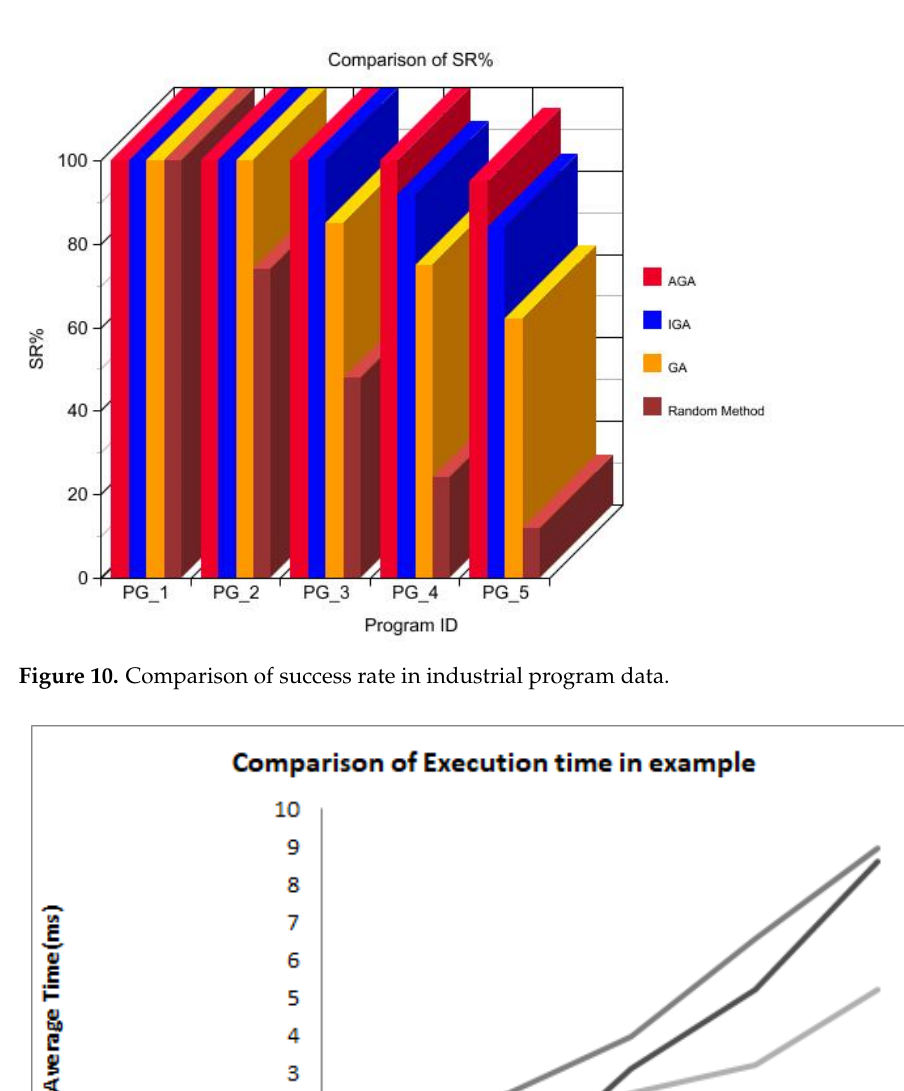
Table 6. Experimental results on the industrial programs.